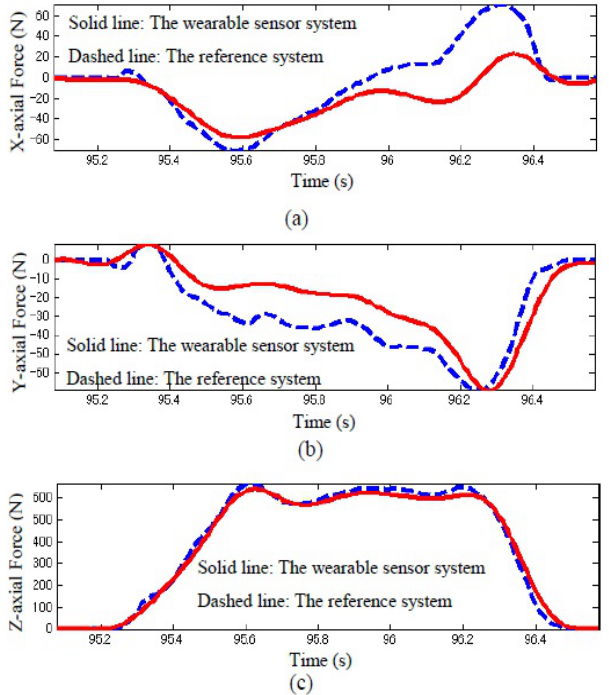
Figure 6. Triaxial GRF measured by the wearable sensor system (solid line) and referenced system (dashed line) during walking trial. ( a ) Comparison results of x-axial force (anterior-posterior direction); ( b ) Comparison results of y-axial force (medio-lateral direction); ( c ) Comparison results of z-axial force (vertical